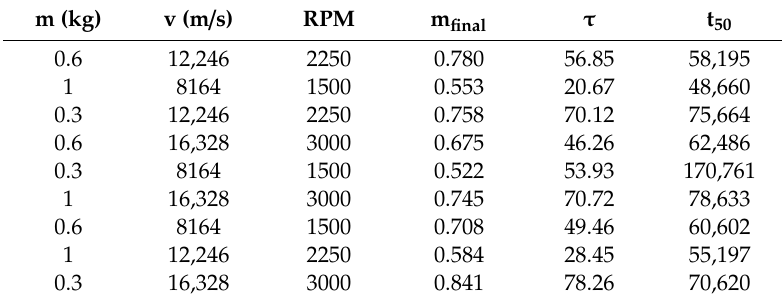
Table 3. m final and τ values for all the mill runs in the first part of the